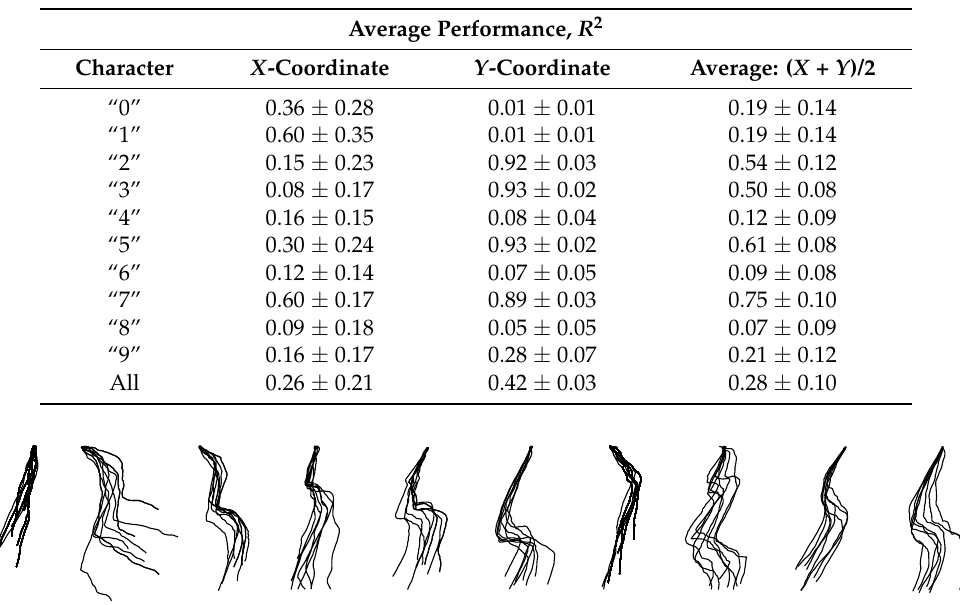
Table 7. Within-group reconstruction performance by the KF: the average accuracy of each numeric character across the five subjects.